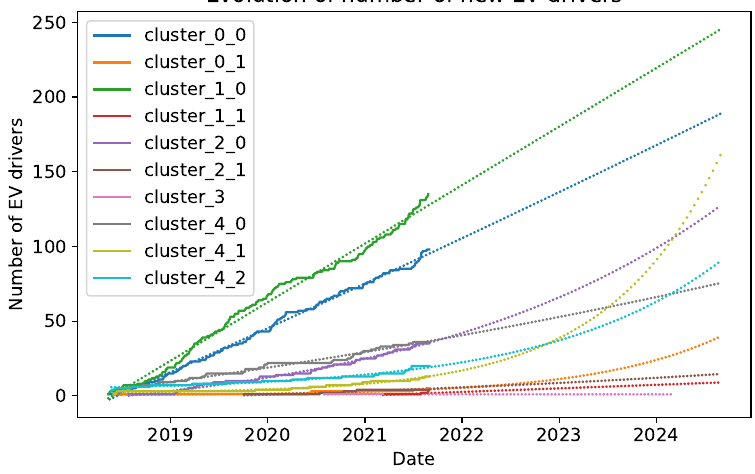
Figure 6. Extrapolation of number of charging sessions per